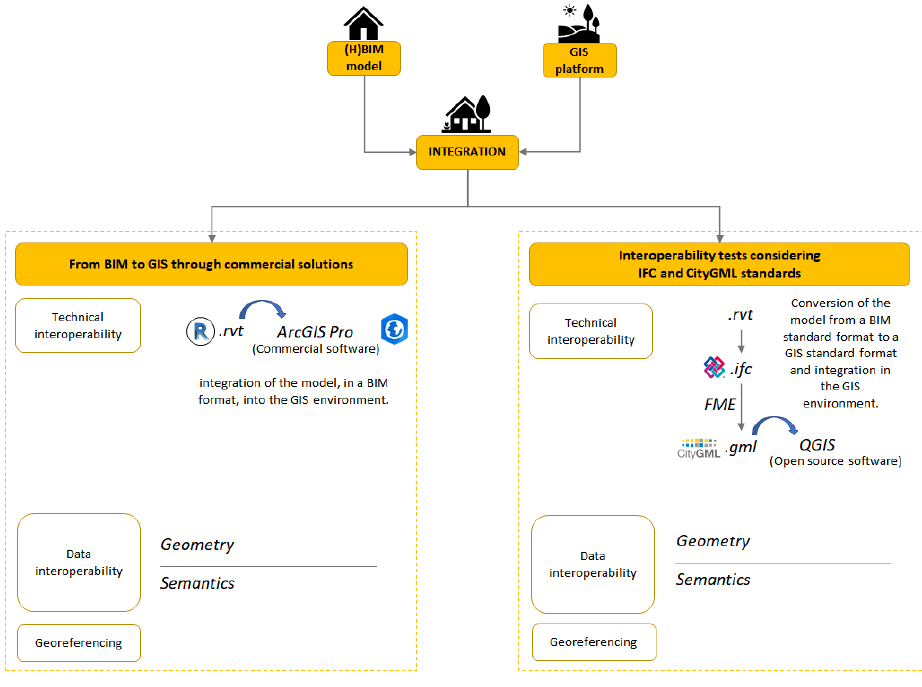
Figure 1. Methodological overview of the research.